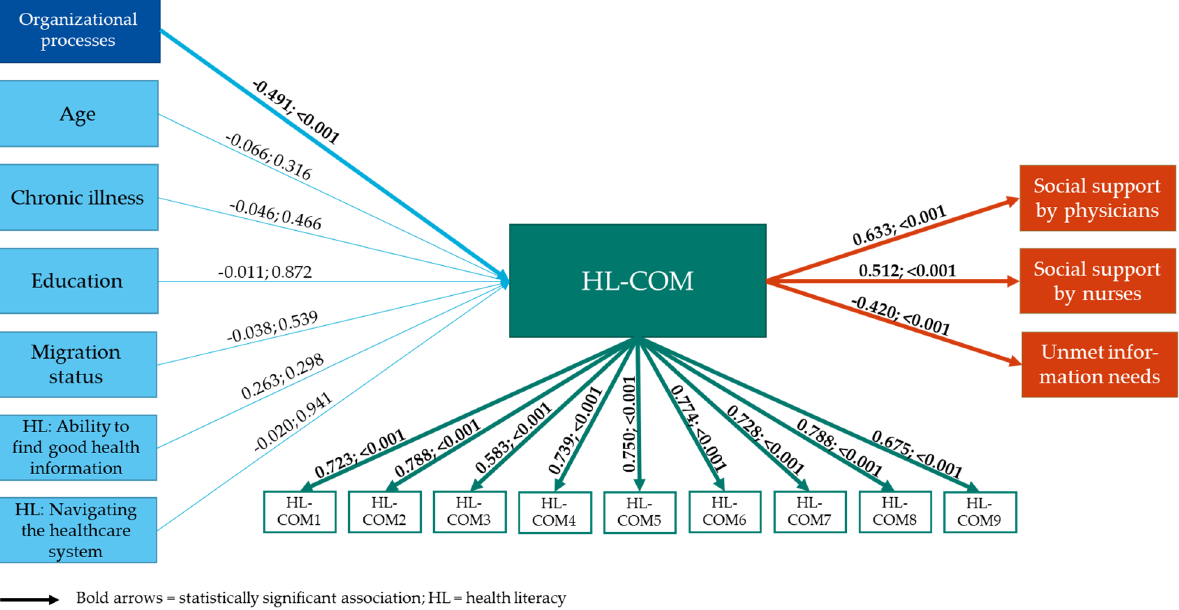
Figure 1. Results of the structural equation model with standardized model estimates and p Table 5. Fit indices of the structural equation model.